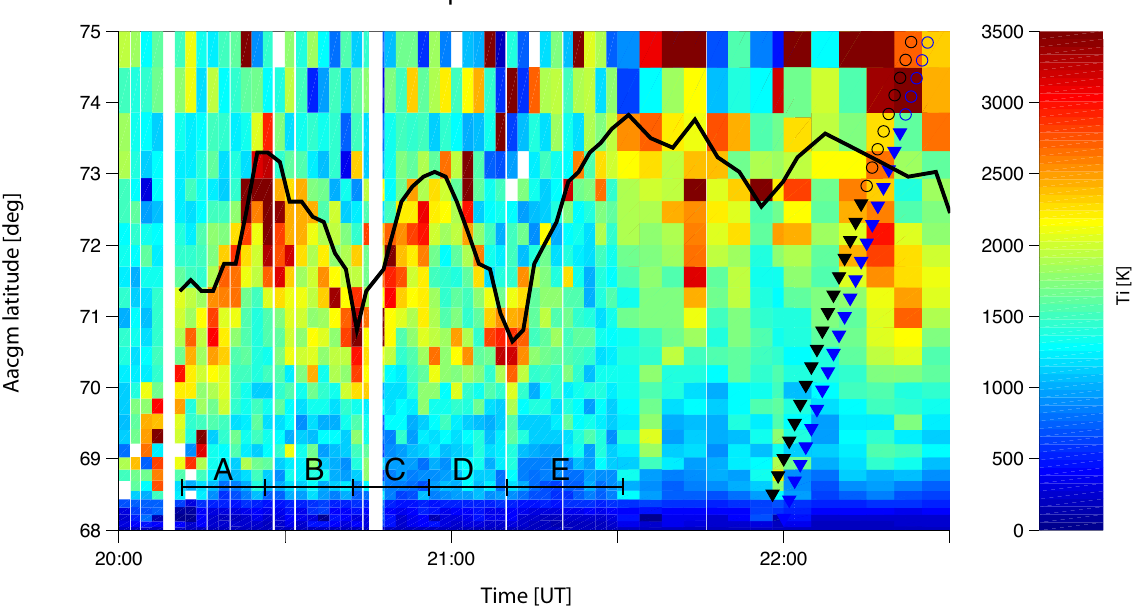
Fig. 4. Ion temperature measured by the VHF radar in the same format as Fig. 3. Time intervals denoted by A to E are shown in the lower part of the